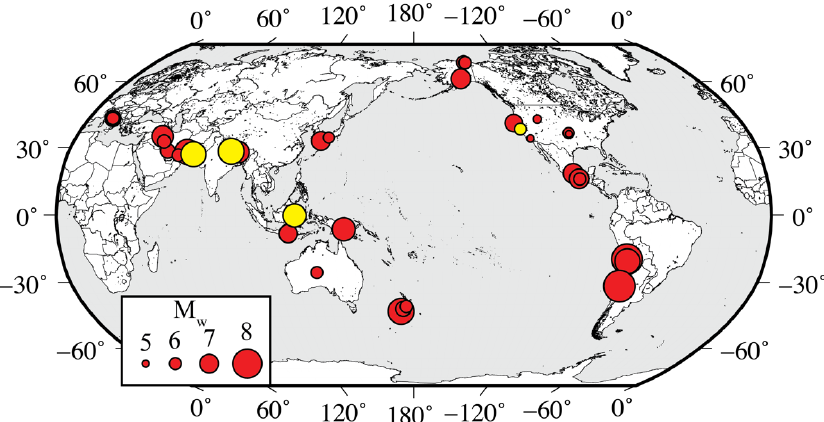
Figure 1. Global distribution of earthquakes (2013–2019) for which geodetic observations contributed to USGS NEIC operational response. Events are scaled by their moment magnitude. The yellow events are highlighted as case studies in this paper. The event locations and magnitudes are listed in Table 1.